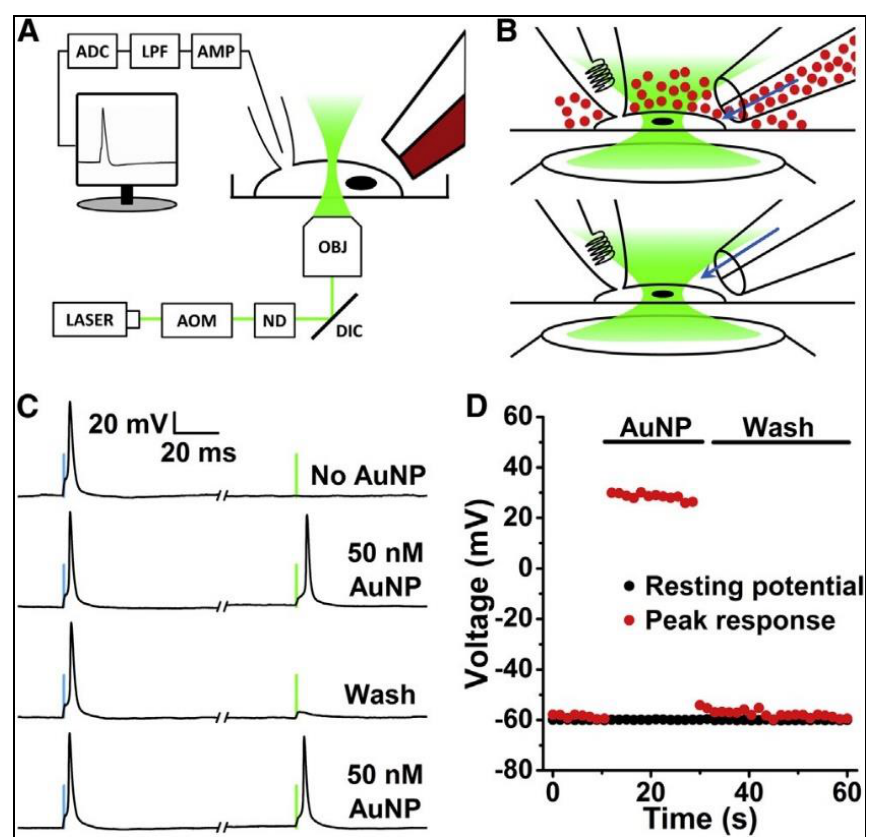
Figure 7. Action potentials were stimulated by a 532-nm laser when the cells were incubated with AuNPs. ( A ) Diagram of the experimental setup (not to scale). The cell was patch-clamped in a whole-cell configuration (pipette on the left) and adding AuNP and perfusion-washing the cells were performed via the theta capillary (right). ( B ) AuNPs were perfused over a patch-clamped DRG neuron through one side of a theta capillary. After a satisfactory optical response was observed, fresh buffer was poured over the cell from the other side of the capillary to wash off the AuNPs. ( C ) Representative traces of current-clamped DRG cells firing action potentials, caused by 2 stimuli: A 300-pA, 1-ms current injection (left, blue bars) and a 174-mW, 1-ms, 532-nm laser pulse (right, green bars). At first, cells only responded to the electrical stimulus, but the addition of AuNPs made the cells sensitive to light. Washing removed enough AuNPs from the cell to prevent the laser from triggering an action potential. The cells regained their optical sensitivity when a second dose of AuNPs was added to the bath. ( D ) The washing showed that the laser effect relies on having a sufficient AuNP concentration near the cell. After the cells were washed, the laser effect vanished in seconds. Abbreviations: AOM: acousto-optic modulator; ND: Neutral density filters; DIC: dichroic mirror; OBJ: Microscope objective; AMP: Amplifier; LPF: Low-pass filter; ADC: Analog-to-digital converter. Reproduced with